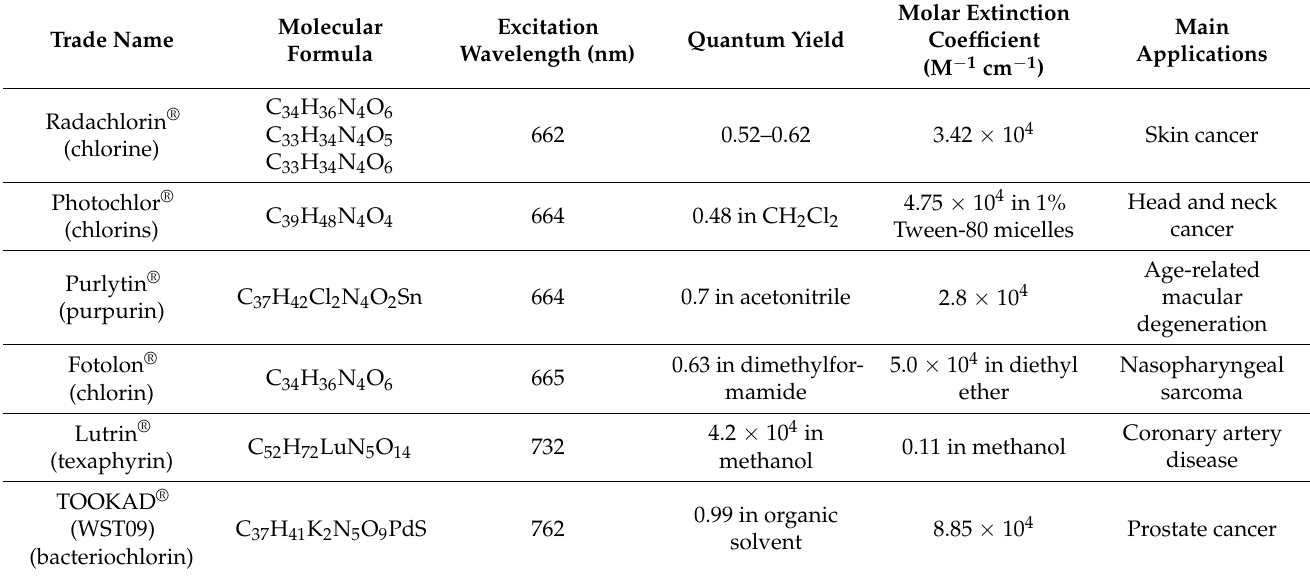
Table 2. Photosensitizers under clinical trials for use in